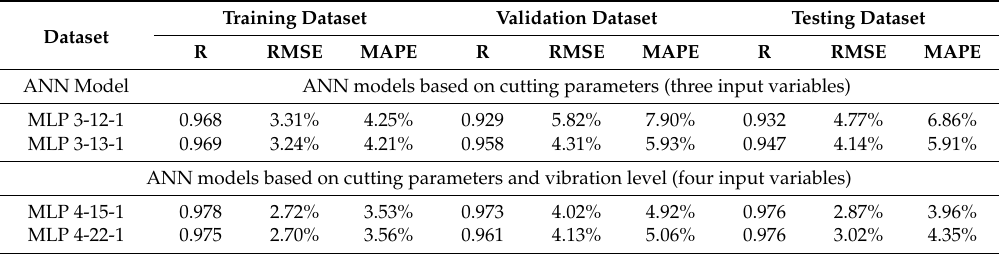
Table 6. Statistical values of neural network